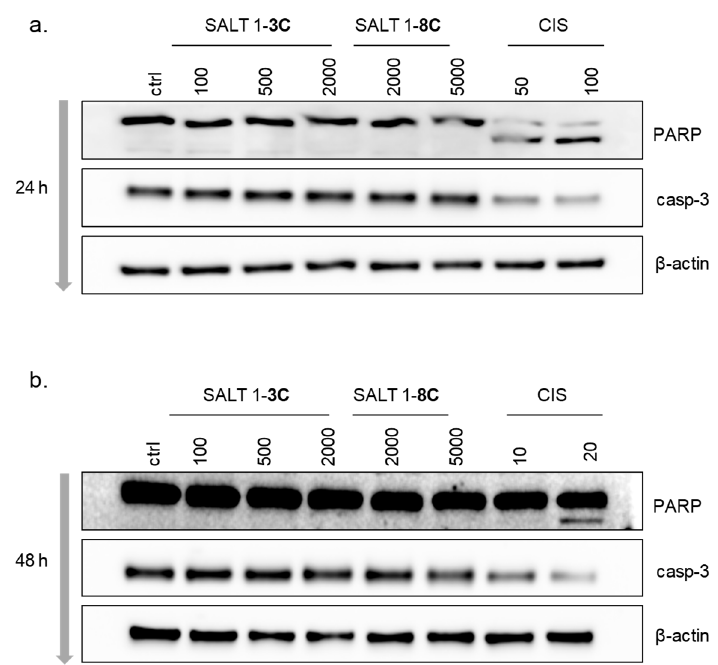
Figure 4. 1- 3C and 1- 8C do not induce apoptosis. Western blot of lysates prepared from A-375 cells treated with different concentration of salt 1- 3C (100, 500, and 2000 nM) and salt 1- 8C (2000 and 5000 nM) for ( a ) 24 h and ( b ) 48 h. Cisplatin (CIS) (50 and 100 µM for 24 h, 10 and 20 µM for 48 h) served as the positive control. Bands of poly(ADP-ribose) polymerase (PARP)/cleaved PARP, caspase-3 (casp-3), and β -actin were detected at 116/89 kDa, 30 kDa, and 42 kDa, respectively. β -actin served as the loading control.